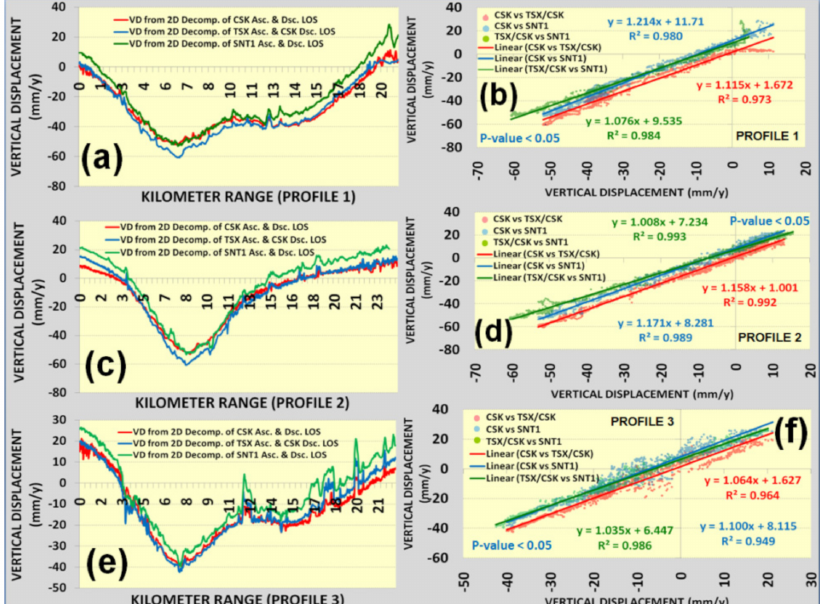
Figure 11. Profiles of vertical displacement velocities: ( a ) profile 1; ( b ) regression analysis for profile 1;( c ) profile 2; ( d ) regression for profile 2; ( e ) profile 3; ( f ) regression analysis for profile 3.